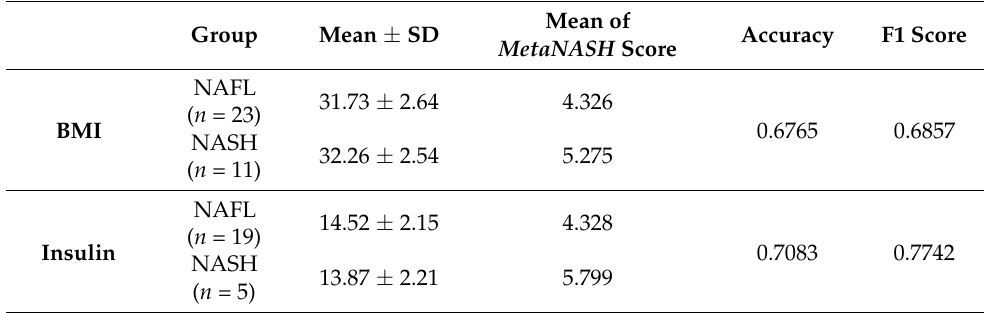
Table 3. The predicting accuracy of the MetaNASH score in NAFL and NASH patients with similar BMI, insulin, and glucose